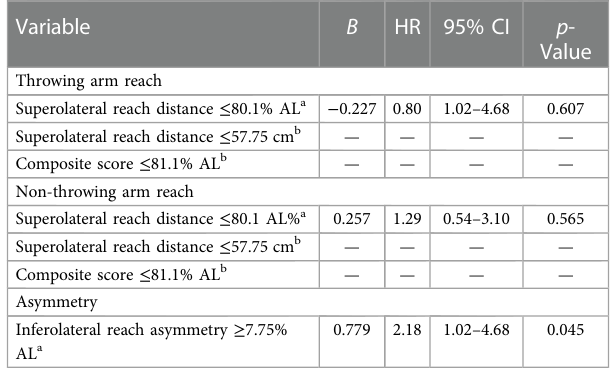
TABLE 4 Results of the Cox proportional hazard survival regression for sport-related injuries of the lower body (i.e., hip, leg, and foot) by throwing